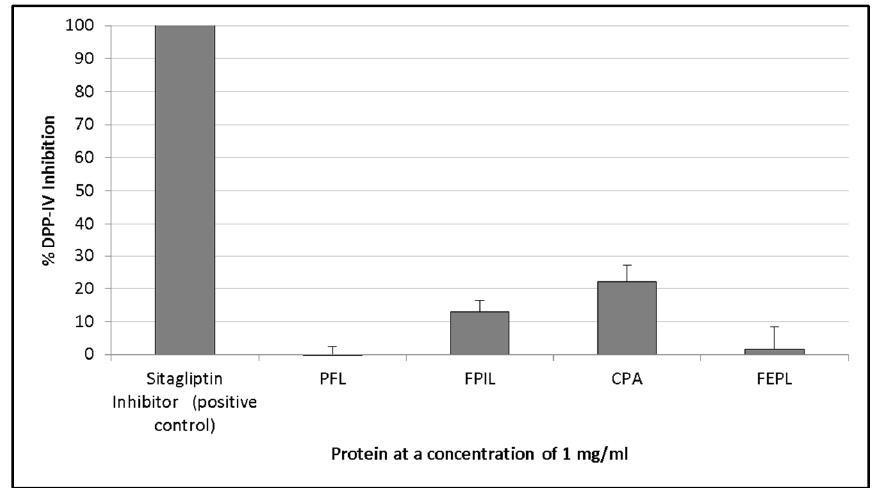
Figure 5. DPP ‐ IV inhibition of several synthesised peptides that were identified in silico from the hydrolysis of oat proteins with papain or ficin, which are both proteases. The activity of peptides was compared with that of a sitagliptin inhibitor (positive control). Peptides were assayed at a concentration of 1 mg/mL. Values are the mean of triplicate samples.